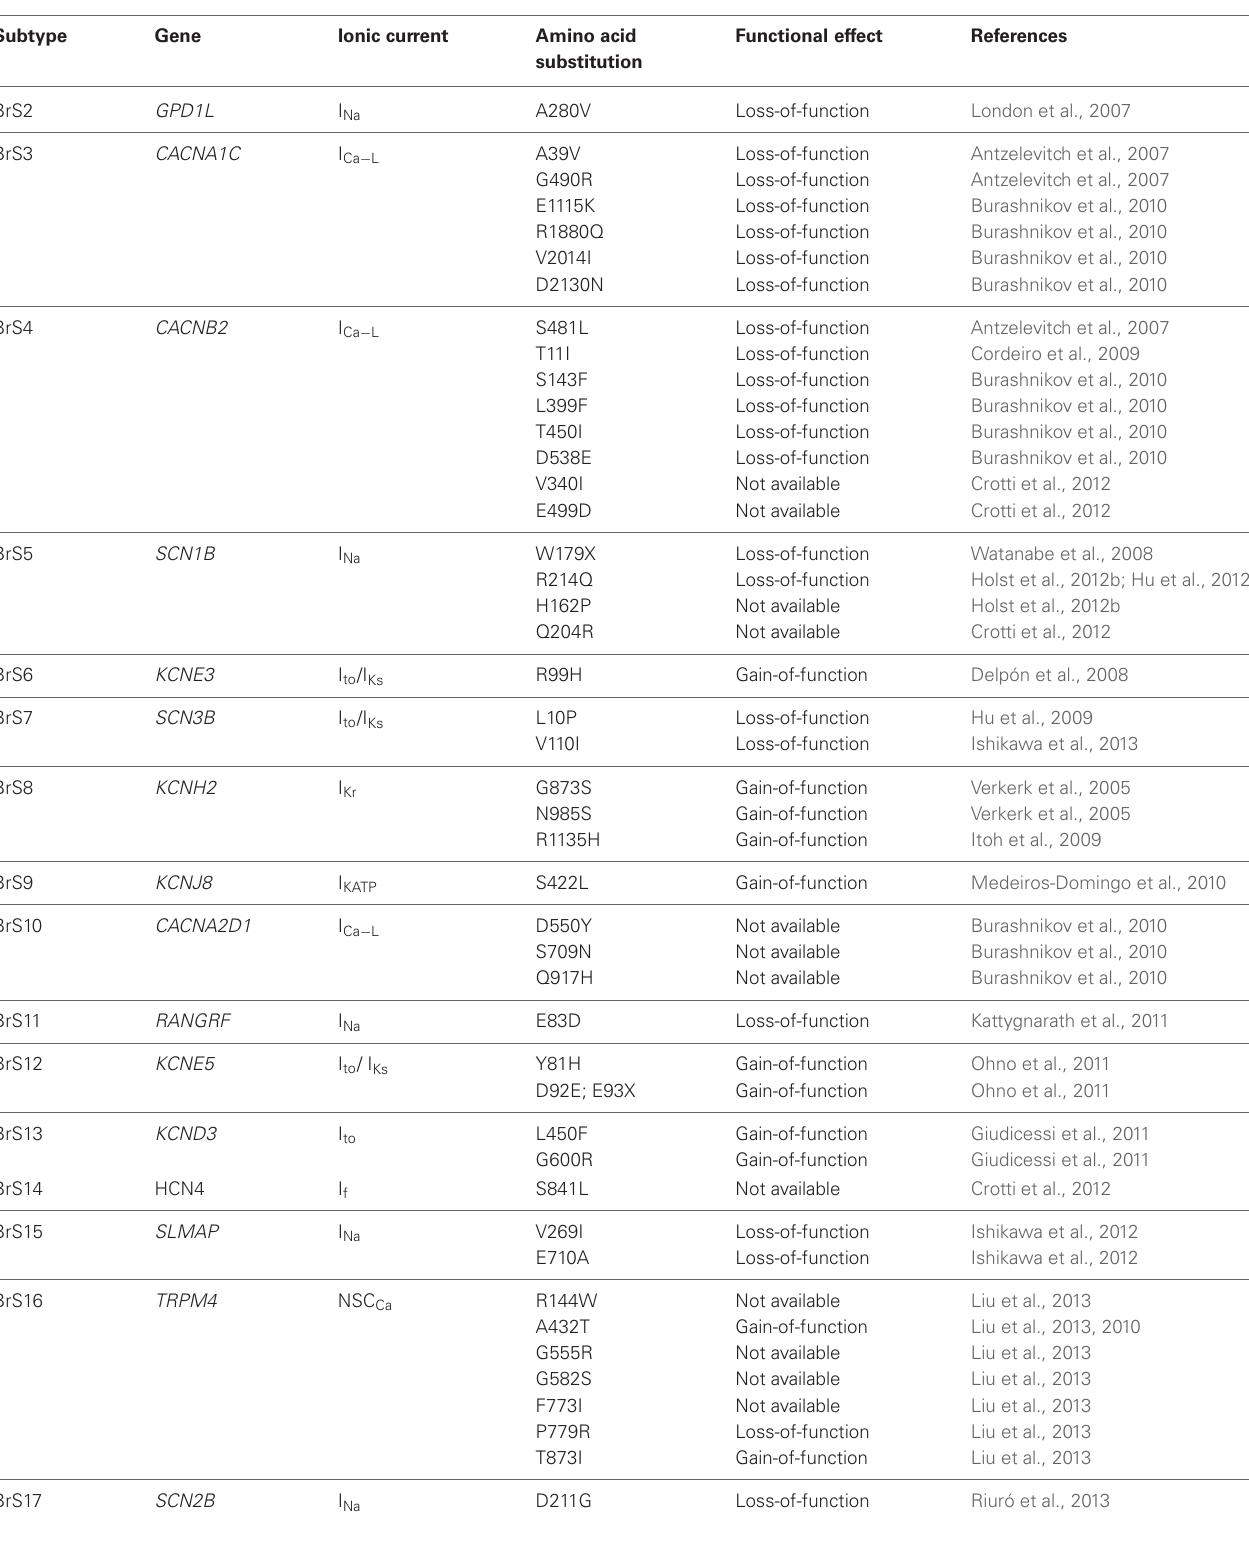
Table 2 | Mutations in genes associated with